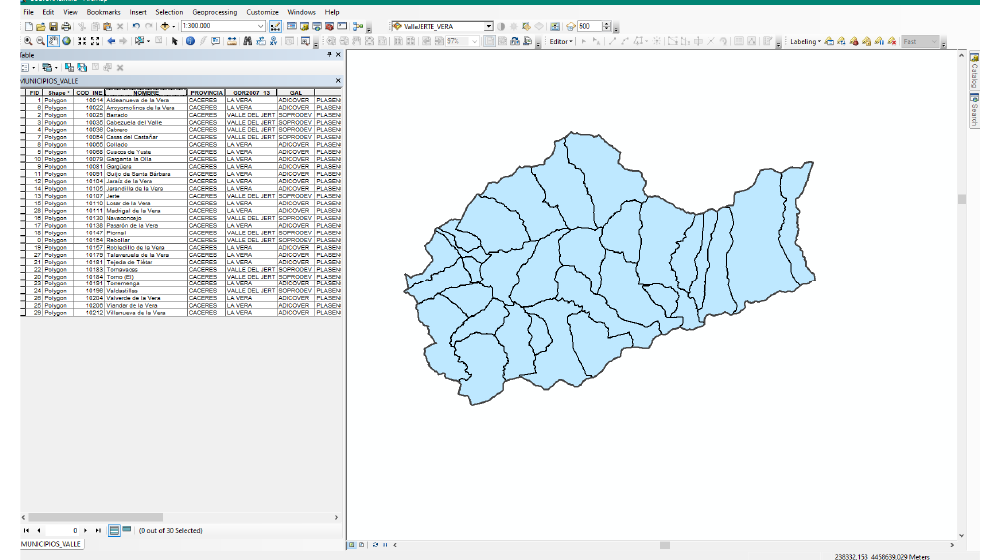
Figure 3. Polygonal layer of the municipalities of the tourist territory with alphanumeric information.